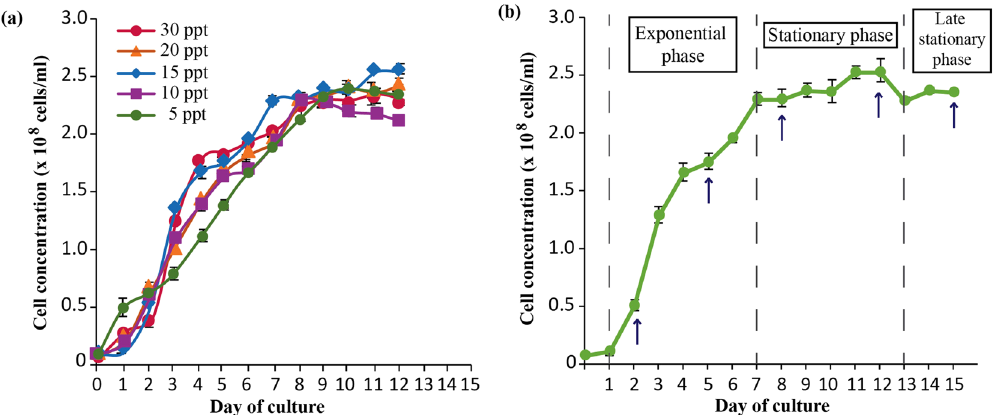
Figure 1. Growth curve of C. vulgaris UMT-M1 (a) cultivated under different salinity measurements of 5, 10, 15, 20 and 30 ppt (with 30 ppt as control). The cultures were harvested at stationary phase at day 12 for further analysis. (b) Cultivated under the selected salinity of 15 ppt. Cultures were harvested at early exponential phase (day 2), mid-exponential phase (day 5), early stationary phase (day 8), mid-stationary phase (day 12) and late stationary phase (day 15). All values presented represent the mean ± SD (n = 3). Arrows ( ↑ ) indicate the day at which the cells from three random replicates were harvested for